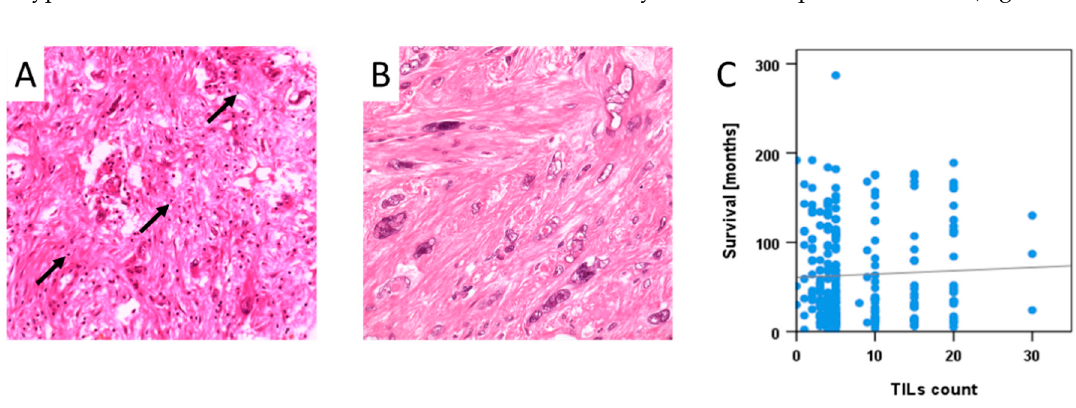
Figure 2. ( A ) and ( B ): representative samples of UPS ( A ) with >4/HPF tumour-infiltrating lymphocytes (TILs) (“positive”) and ( B ) without TILs ( ≤ 3/HPF, “negative”). Pictures are representative micrographs of cores on an H&E stained tissue microarray. Black arrows pointed at TILs. Magnification 20×. ( C ): Relationship between counts of tumour-infiltrating lymphocytes (TILs) and survival. No significant correlation was found (R 2 = 0.0002; p > 0.05).